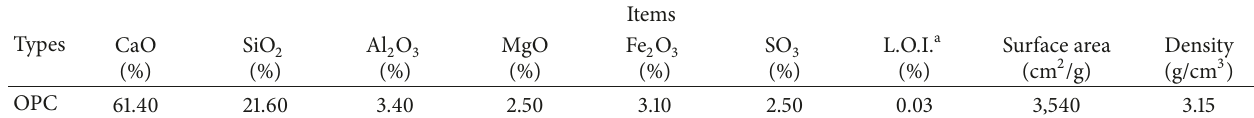
Table 1: Chemical components and physical properties of cement.